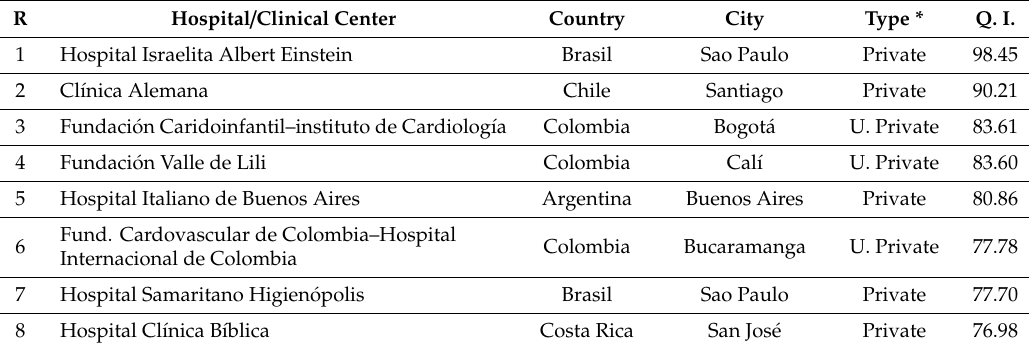
Table 3. Sample from ranking of hospitals in “ Am é rica Econom í a